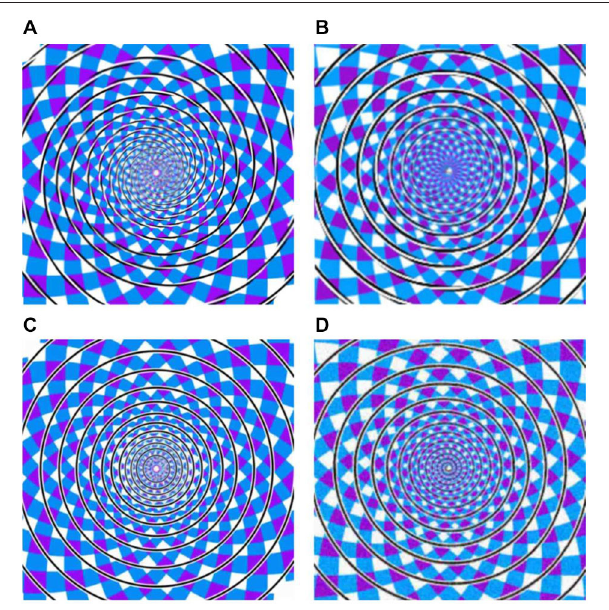
FIGURE 1 | (A) Twisted Circles (twisted cords with concentric circles), (B) Twisted Spiral (twisted cords with spiral shape), (C) the Parallel Circles (parallel cords with concentric circles), (D) the Parallel Spiral (parallel cords with spiral shape). Note that these example stimuli differ slightly from the actual